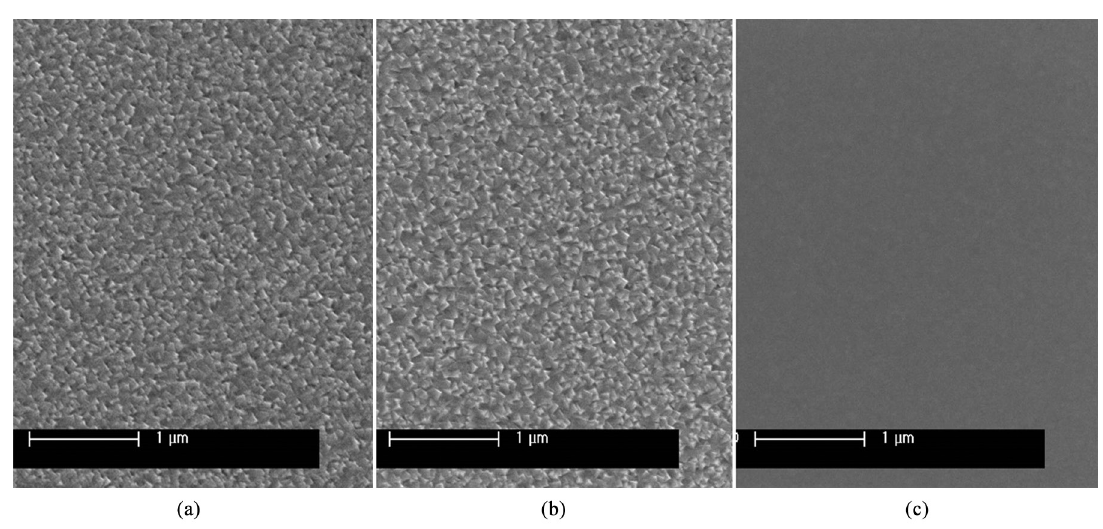
Figure 2. SEM images of the film 1# (a), 2# (b) and 3#